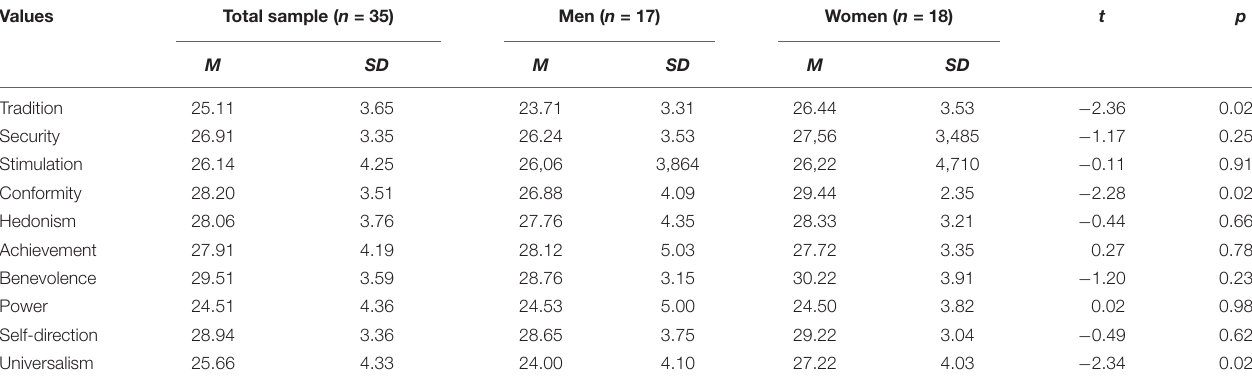
Values, means on a scale of 7 to 35 (see section “Materials and Methods”).